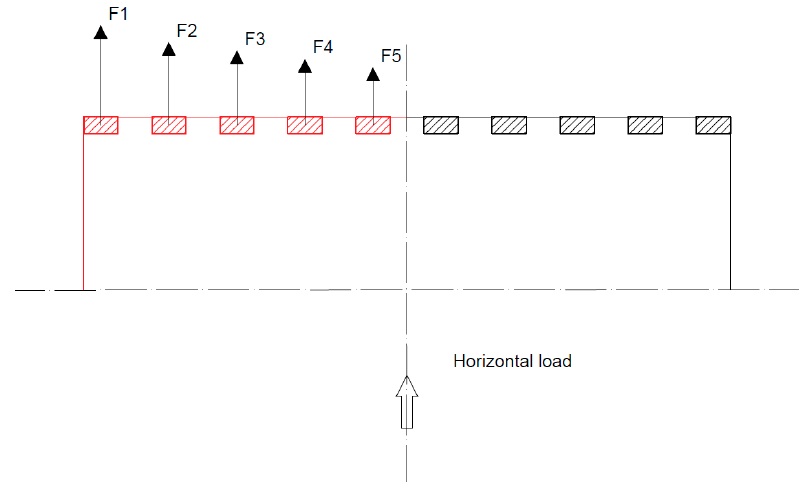
Figure 8. Layout for the calculation of β coefficient.